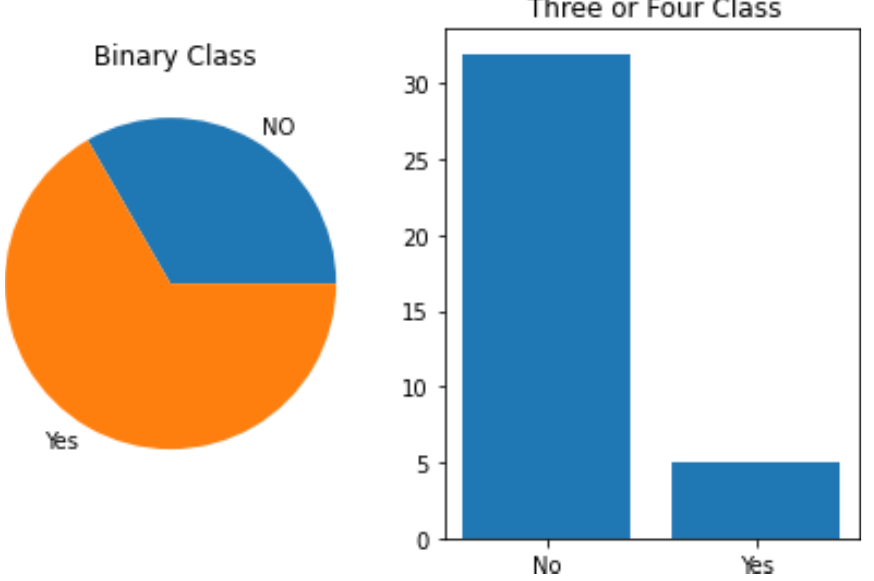
Figure 4. Analysis of binary class and multi class for AD and its stages detection.